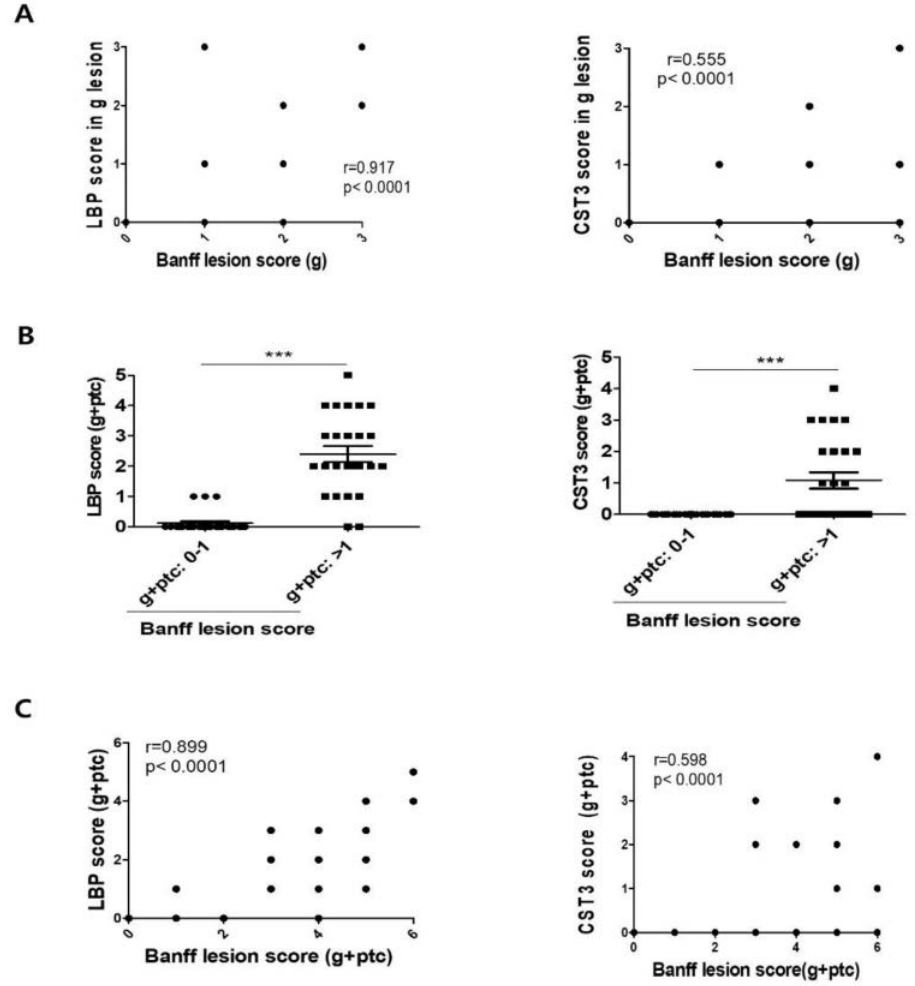
Figure 6. Association of urinary exosomal biomarkers with Banff scores in kidney allografts. ( A ) Cor- relation between the Banff lesion score (g) with LBP and CST3. ( B ) The statistical significance of microcirculatory inflammation (g + ptc score) was determined using two-tailed Mann–Whitney U test. *** p < 0.001. ( C ) Correlation between the Banff lesion score (g + ptc) with LBP and CST3. The results were categorized as strong (r = 0.7–1) and moderate (r = 0.5–0.7) according to the degree of association. Statistical significance was determined using two-tailed Mann–Whitney U test. *** p < 0.001. ABMR, antibody − mediated rejection; NOMOA, no major abnormality; TCMR, T cell − mediated rejection; CST3, Cystatin C; LBP, lipopolysaccharide − binding protein; g, glomeruli; ptc, peritubular